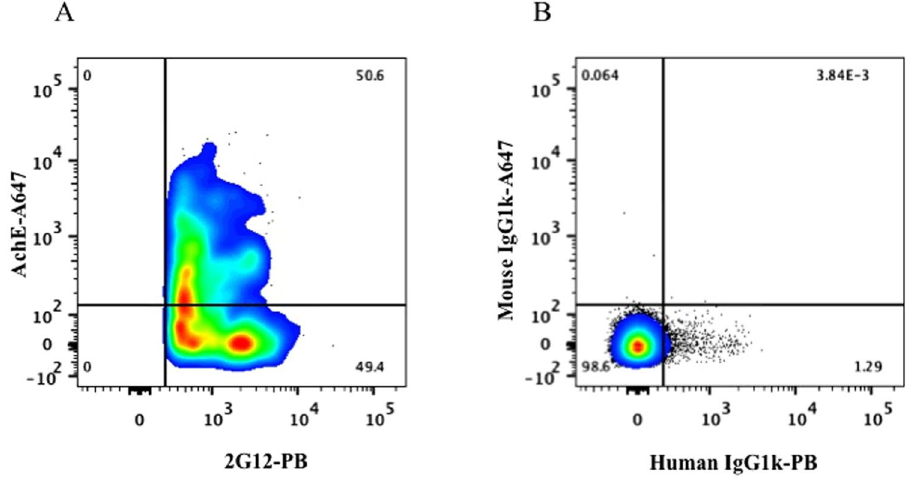
Figure 5. Analysis of EVs expressing gp120 in HIV LAI.04 preparation. ( A ) A preparation of HIV LAI.04 (containing both viruses and EVs) was incubated with CD81-MNPs and the captured particles were stained with anti- AChE-Alexa Fluor 647 and anti-gp120 2G12-Pacific Blue antibodies. ( B ) Isotype control: Staining with mouse IgG1k-Alexa Fluor 647 and human IgG1k-Pacific Blue. Presented are data from one representative experiment out of